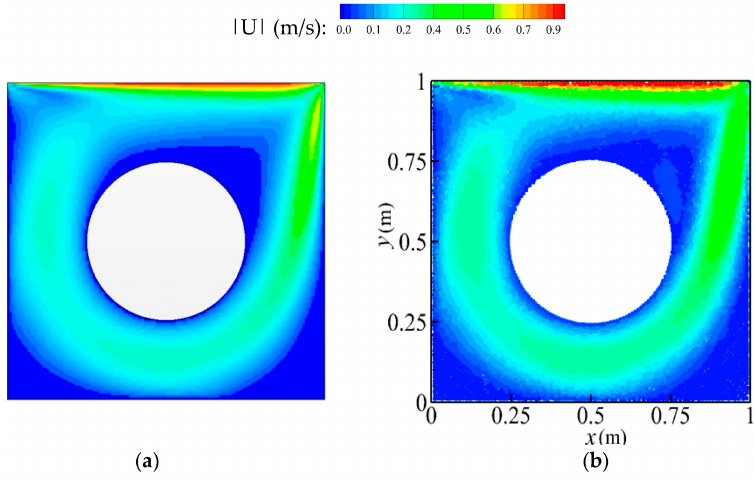
Figure 12. Velocity amplitude patterns of the lid-driven flow with an inside cylinder computed by: ( a ) OpenFOAM; and ( b ) ISPH